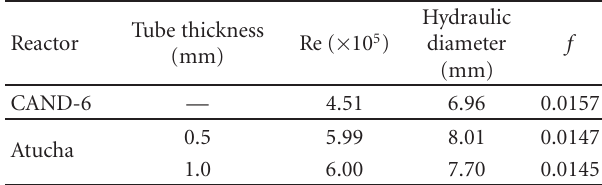
Table 12: Flow parameters for CARA in each reactor.